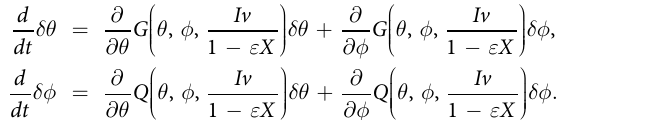
Methods Integration of equations.